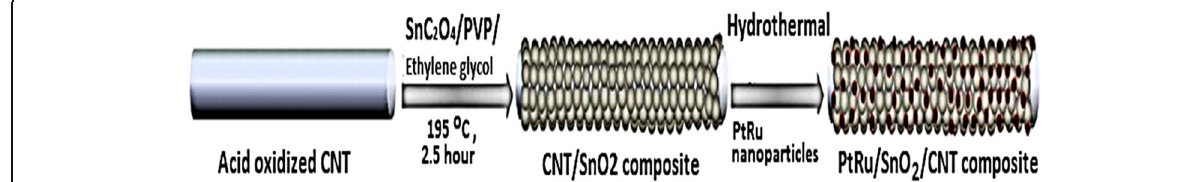
Fig. 8 Illustrates the schematic diagram for the formation of PtRu/SnO2/CNT composite